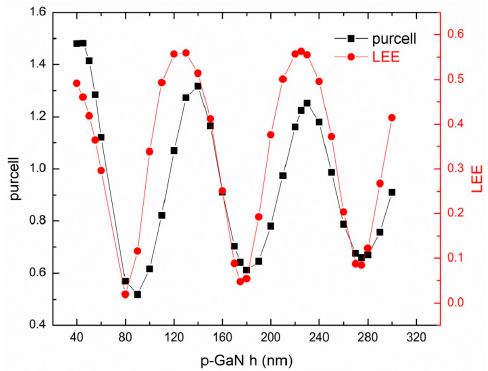
Figure 2. The effect of p-GaN thickness on the Purcell factor and light extraction efficiency (LEE) for Figure 2. The e ff ect of p-GaN thickness on the Purcell factor and light extraction e ffi ciency (LEE) for flip-chip LED (FCLED). flip-chip LED